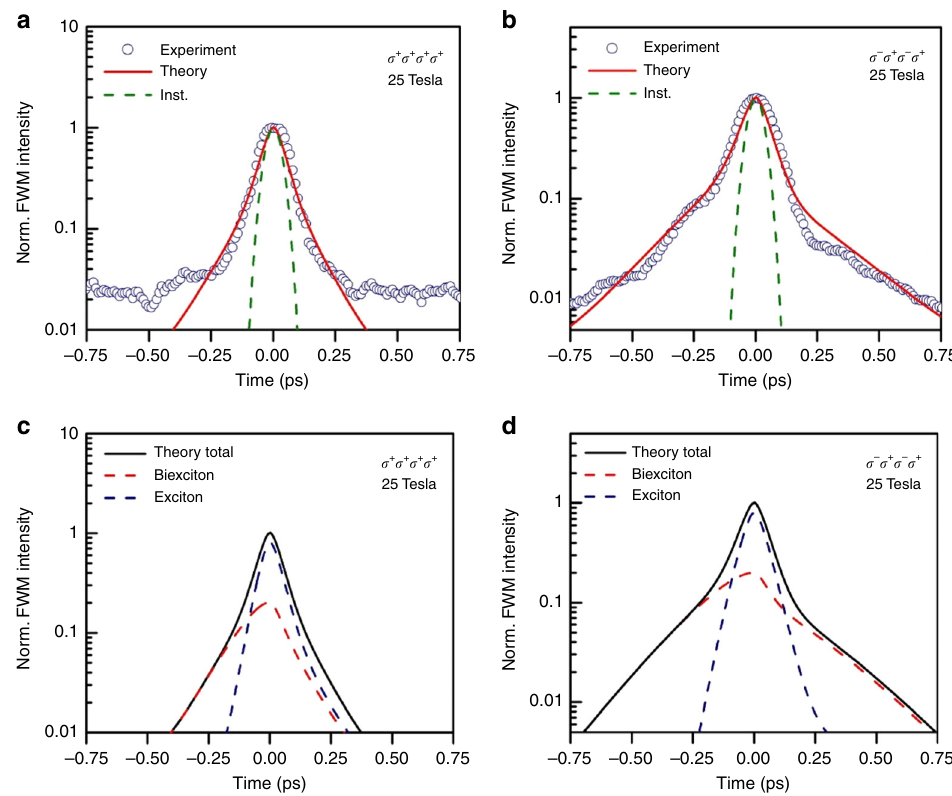
Fig. 4 Time-integrated FWM at high magnetic fi elds. Time-integrated FWM intensity as a function of the time delay τ at 25 T for two different polarization sequences ( σ + σ + σ + σ + ) ( a ) and ( σ − σ + σ − σ + ) ( b ), where the individual polarizations correspond to the laser pulses A * , B, C, and detection, respectively. The time delay T between pulses B and C is kept fi xed at 0 fs. Blue circles are the experimental data, whereas the red lines are the time-integrated FWM calculated using time-dependent DFT. The dashed green lines correspond to the instrumental response. The background noise level is lower for ( σ − σ + σ − σ + ) polarizations, due to better rejection of scattered light originating from the excitation laser pulses. c , d The fi nal calculated time-integrated FWM curves (black line) are plotted together with contributions arising solely from the two-particle exciton correlations (blue dashed line) and four-particle biexciton correlations (red dashed line) for the two polarization